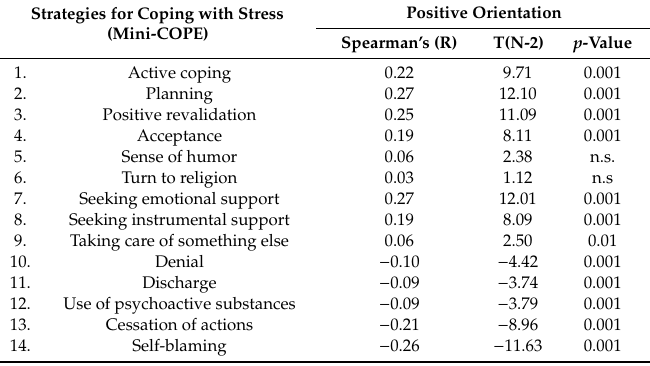
Table 2. Spearman’s rank correlation coe ffi cient (R) between positive orientation and strategies for coping with